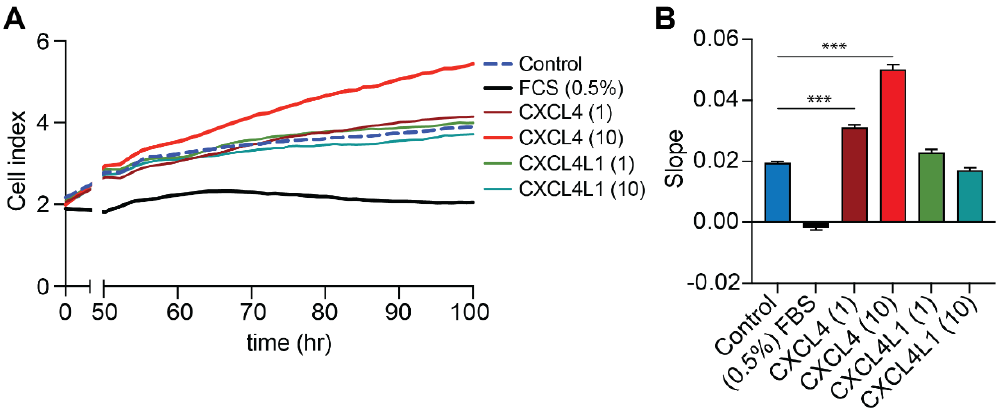
Figure 5. Influence of CXCL4 and CXCL4L1 on proliferation of VSMCs. Cell growth was monitored in 96 ‐ well electronic microtiter plates for 9 days and ( A ) plotted as mean cell index over time ( n = 5). ( B ) The rate of cell growth expressed as slopes between 50 and 100 h of proliferation from the curves from ( A ), mean ± SD. *** p < 0.001, n = 5, one ‐ way ANOVA with Dunnett’s post ‐ test.